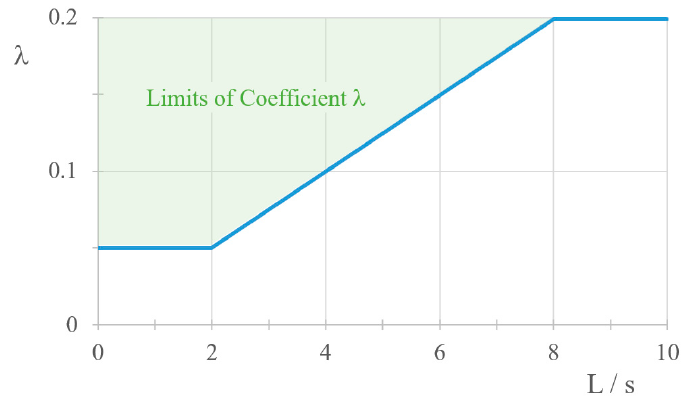
Figure 1. Values of the λ coefficient.